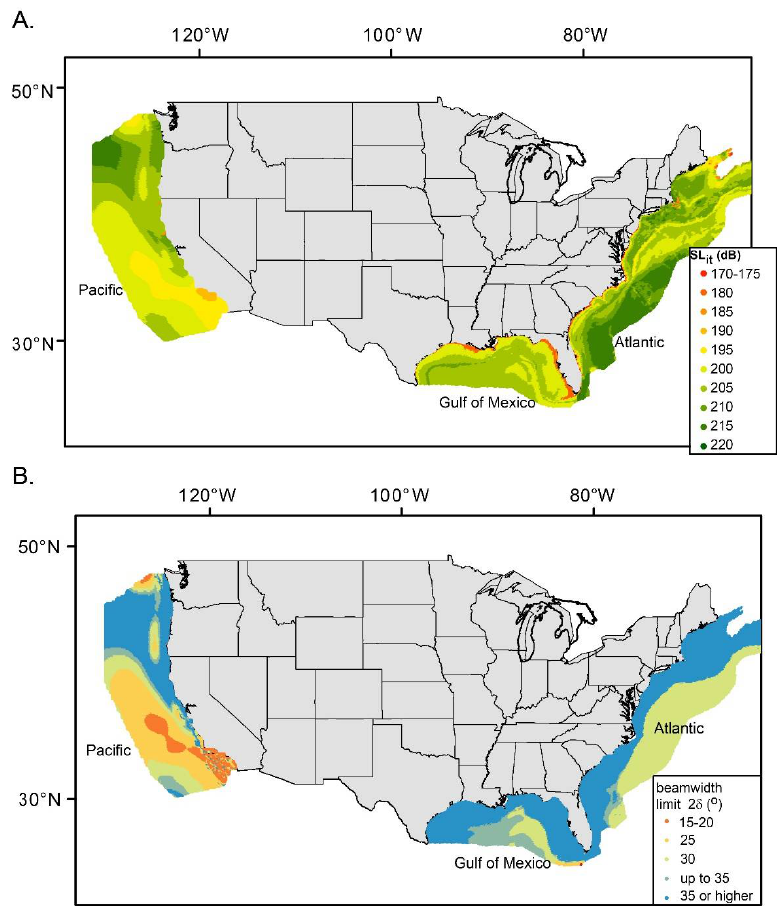
Figure 7. ( A ) SL it calculated using R t from Equation (4) based on p = 0.01 and the maximum cetacean density across all reported species for each grid block for the U.S. Atlantic and Gulf of Mexico margins [65] and the U.S. Pacific margin [68] . Comparable R t map in Figure S3. Summary information about the species and densities is given in Table S1. The SL it calculation assumes spherical spreading, which should be valid even to very shallow water depths for the frequencies of HRG instruments, and SPL B = 160 dB re 1 μPa. ( B ) Beamwidth limit 2δ based on a Monte Carlo approach, using the maximum cetacean density (Figure S1) in each grid block and p = 0.01. Calculation completed with an analytical fit to empirical results from Monte Carlo simulations, using 10 5 realizations for each Monte Carlo run and assuming animals distributed according to a gamma function between the surface and the seafloor or 1000 m in the water column, whichever is shallower. The analytical fit overestimates the true beamwidth limit by a maximum of ~3° under certain conditions. Details of the animals’ distribution in three dimensions are given in the text, and an example distribution is shown in Figure S8. Bathymetry is from [69] .